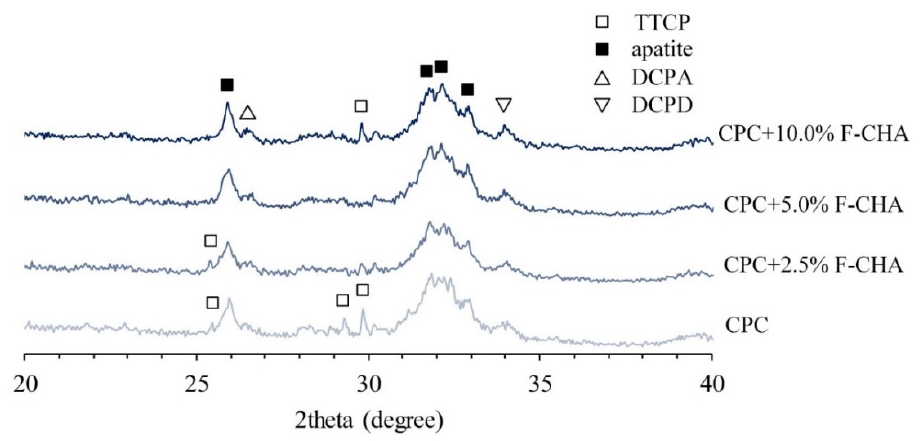
Figure 8. XRD phase identification of CPC composites with different ratios of ferulic acid-carbonated apatite nanorods after immersion in TBS for 1 day.